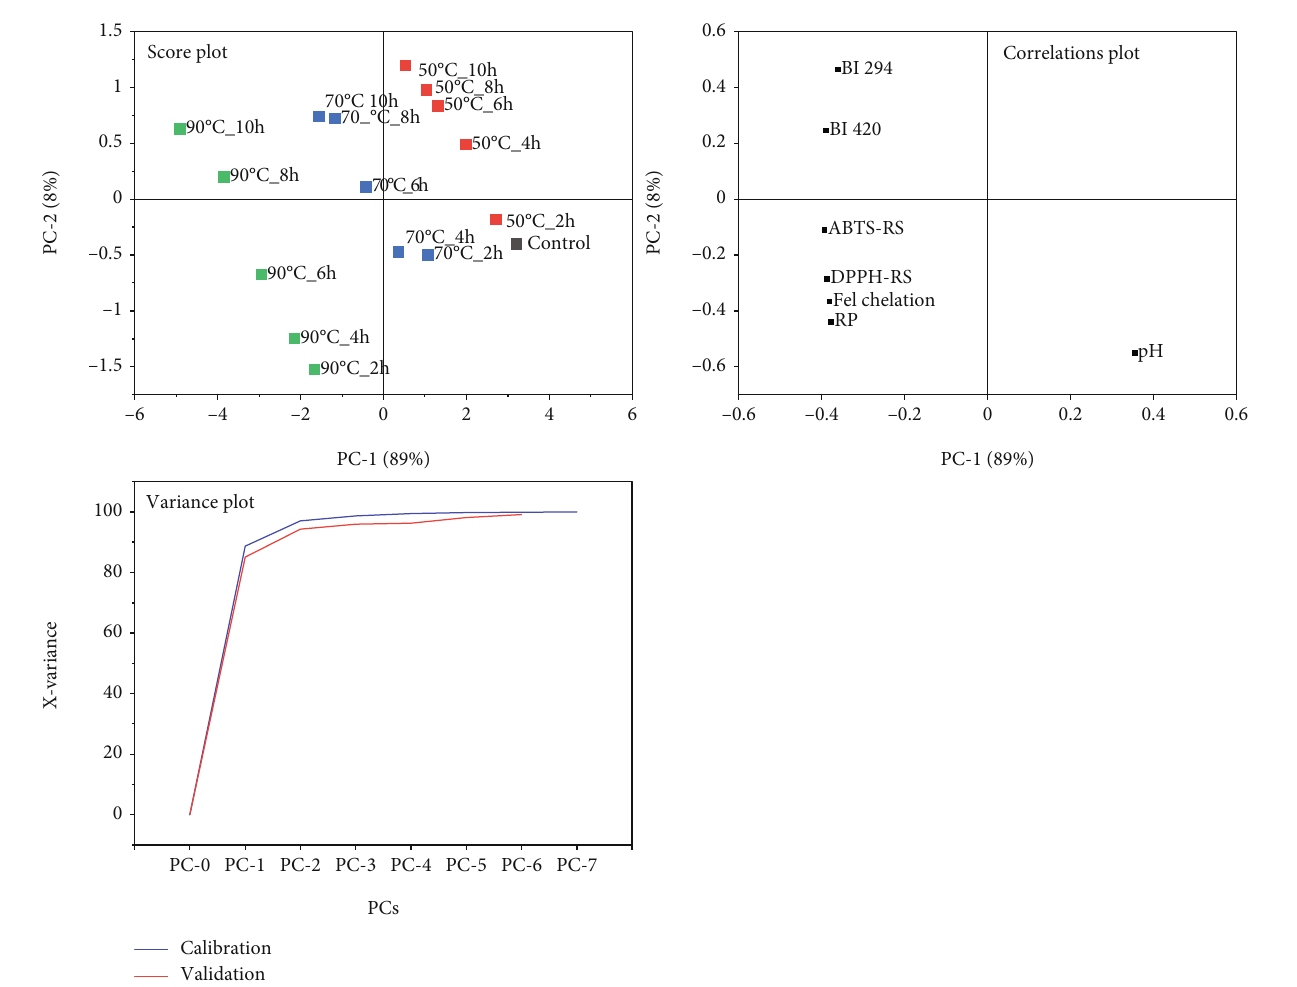
Figure 8: PCA plots of independent (scores) and dependent (loadings) variables for BSFL-Glu antioxidant